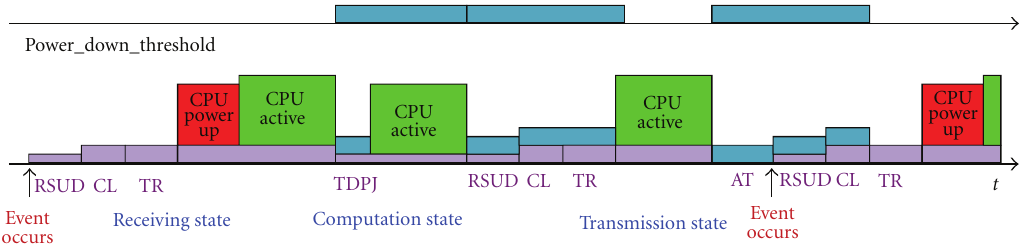
Figure 18: Energy diagram of 1 CPU power up in one system cycle for closed model (not drawn to scale).